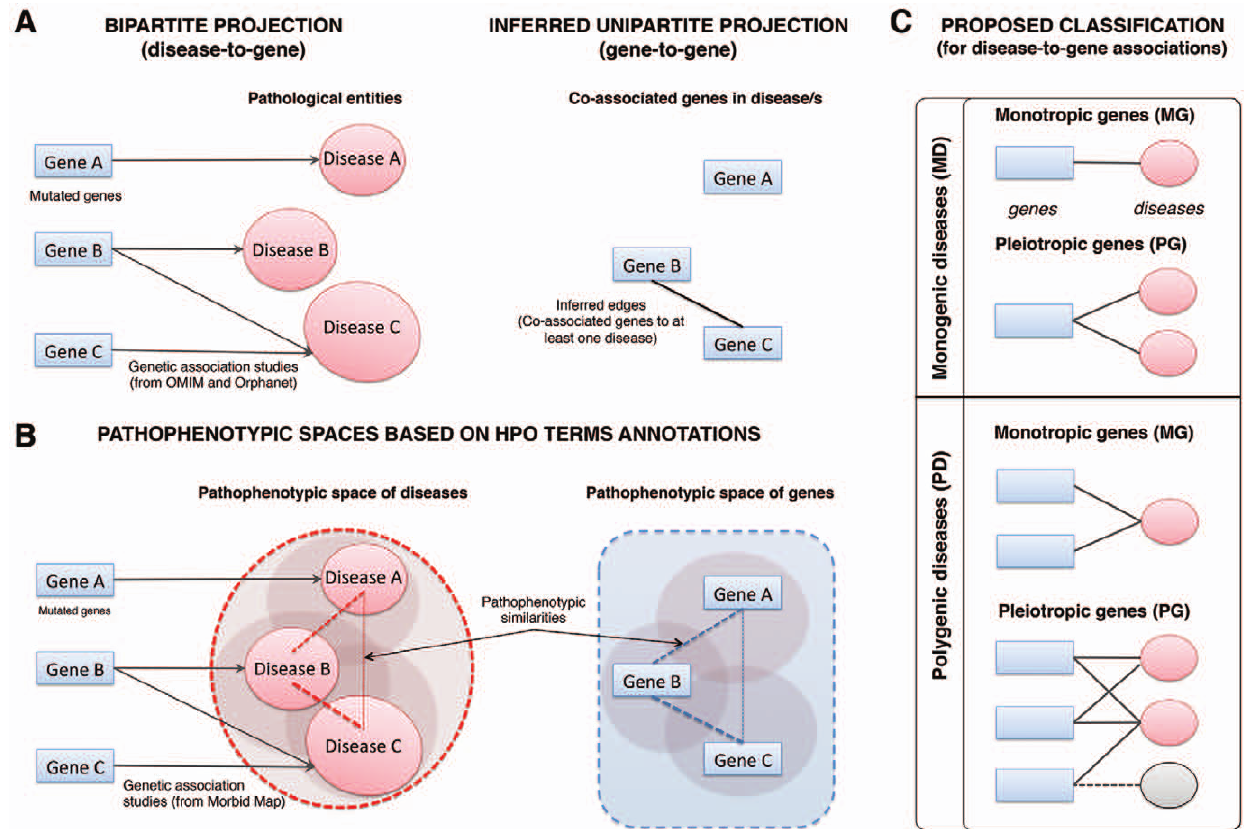
Figure 1. Schematic representation of distinct disease-to-gene relationships. Different disease associations between genes using (A) the data from genetic disease databases or (B) their associated pathological phenotypes. (A) The co-associations of genes in disease/s allow the inference of gene-to-gene projection (unipartite) from the disease-to-gene projection (bipartite). In this case Gene B and Gene C are co-associated with Disease C. (B) The HPO annotations of genetic diseases allow the description of pathophenotypic space for genes and calculation of the semantic similarity (pathophenotypic similarity) between them. In this case, novel relationships emerge as occur between Gene A and Gene B or Gene A and Gene C. (C) The proposed classification in this work: monogenic disease and monotropic genes (MD-MG), monogenic disease and pleiotropic genes (MD-PG), polygenic disease and monotropic gene (PD-MG), polygenic disease and pleiotropic gene (PD-PG). It is noteworthy that genes present in the MD-PG subset can also be present in the PD-PG subset (dashed line linked to monogenic disease in grey).